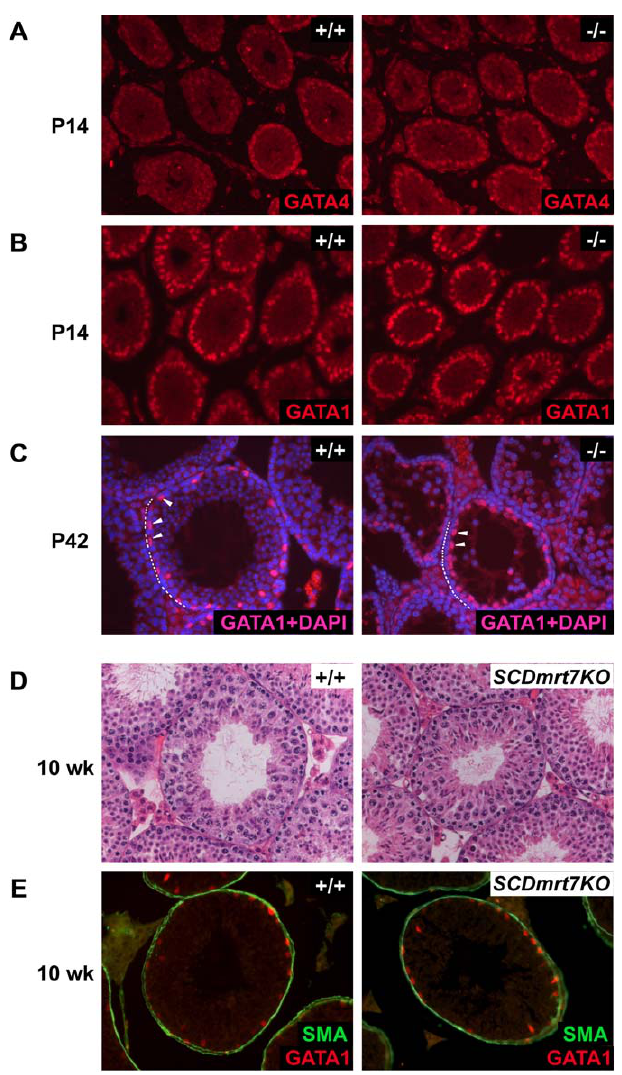
Figure 6. Abnormal Sertoli Cell Organization in Dmrt7 Mutant Testes (A) Testes from P14 wild-type and Dmrt7 mutant mice were sectioned and stained with antibody to GATA4. (B) P14 testis sections stained with antibody to GATA1. At P14, GATA4 and GATA1 levels are similar in wild-type and mutant Sertoli cell. (C) Wild-type and mutant testis sections double-stained with antibody to GATA1 (red) and DAPI (blue). Most Sertoli cell nuclei were adjacent to the basal membrane in wild-type, but mutant Sertoli cells were displaced in some tubules (arrowhead). White dotted line indicates position of basal membranes. (D) Testis sections from 10-wk-old wild-type and Sertoli cell-specific Dmrt7 mutant (SC-Dmrt7KO) mice stained with hematoxylin and eosin. Spermatogenesis and spermiogenesis are normal in SC-Dmrt7KO testis. (E) Testis sections from 10-wk-old wild-type and SC-Dmrt7KO mice stained with antibodies to GATA1 (red) and smooth muscle actin (to outline seminiferous tubules; green). Sertoli cell nuclei are positioned normally near the basal membrane in SC-Dmrt7KO mice.